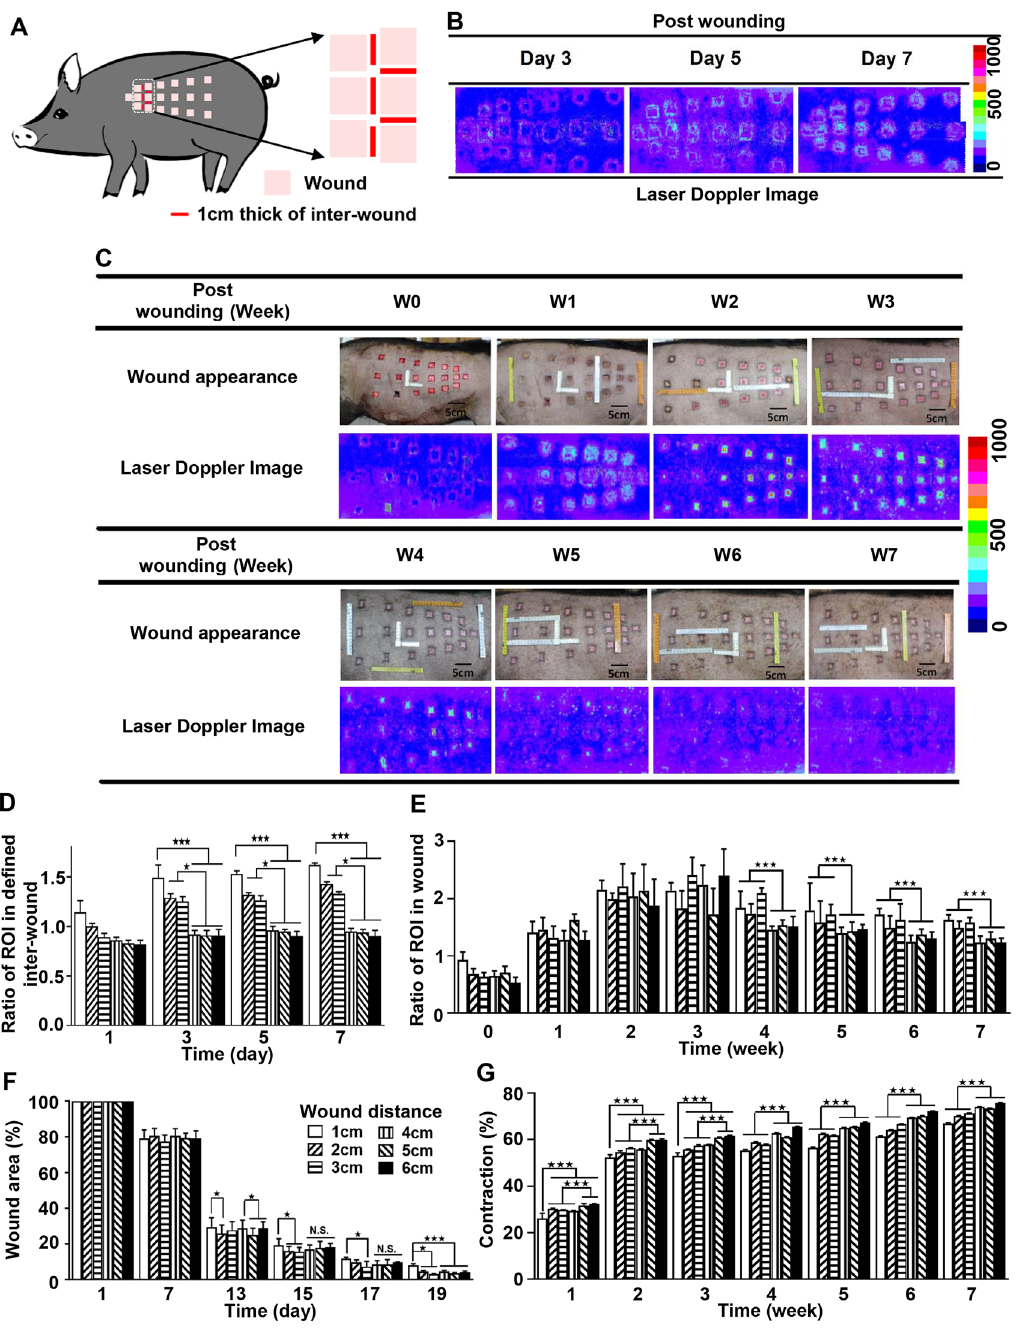
Figure 4. Studies to determine optimal distance between adjacent wounds sized 2.5 cm × 2.5 cm × 0.6 cm. Inter-wound distances of 1, 2, 3, 4, 5, and 6 cm were created for full-thickness wounds on the dorsal skin of two Lanyu pigs. ( A ) Schematic illustration indicates skin wounds created on a Lanyu pig with inter-wound distances of 1–6 cm from anterior skin to posterior skin. The opposite arrangement was established on the other pig. The red line indicates 1 cm-thick area from the midline of the inter-wound. ( B ) The laser Doppler images of the dorsal skin with various distances between adjacent wounds were determined on days 3, 5, and 7 postoperatively. ( C ) The appearance and laser Doppler images of the dorsal skin with wounds included were taken at weeks 0–7 postoperatively. ( D ) The ratios of ROI of various inter-wound distances at day 0, 3, 5, 7 were measured in comparison to the ROI of respective normal skin and data are expressed as mean ± SD ( n = 10 for 2–6 cm of distances and n = 6 for 1 cm of distance). ( E ) The ratios of ROI of wounds with various distances of adjacent wounds were measured as indicated ( n ≥ 6). ( F ) The closure of wounds with various distances of adjacent wounds was measured as the percentage of wound area when compared with each original wound size ( n ≥ 6). ( G ) The percentages of wound contraction with various distances of adjacent wounds as indicated were measured with time postoperatively ( n ≥ 6). Statistical significances of each parameter among various inter- wound distances were analyzed through